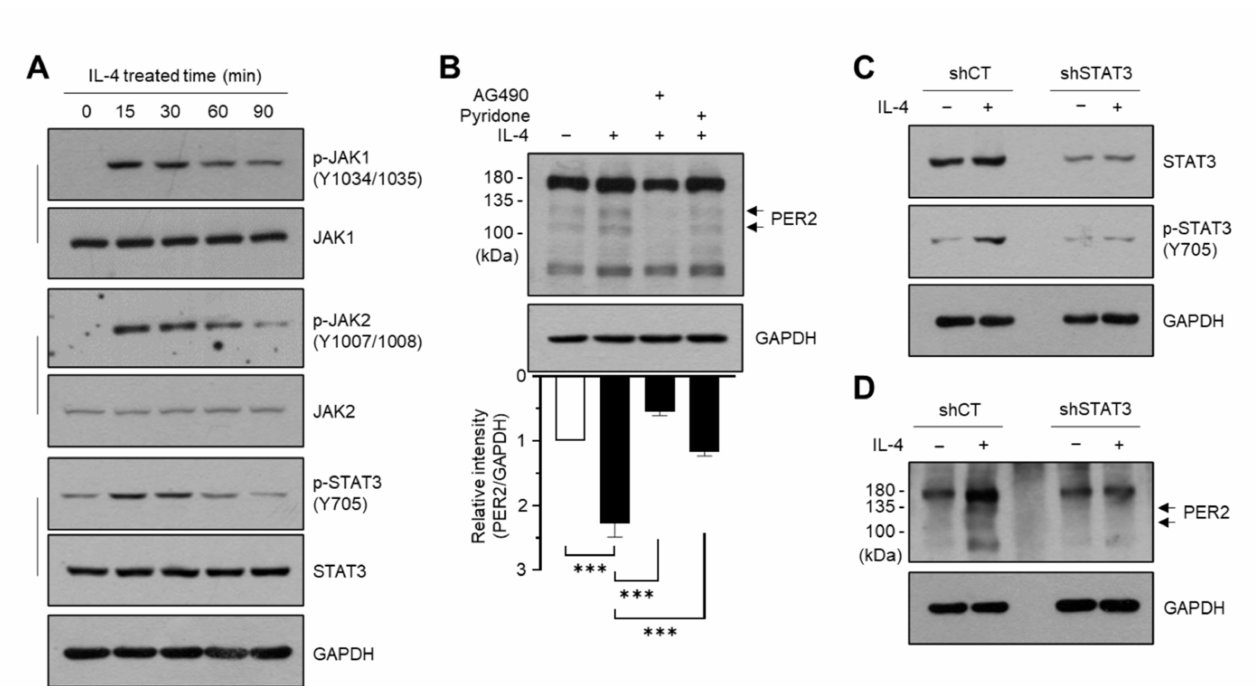
Figure 2. Role of the JAK/STAT3 pathway in IL-4-induced PER2 expression. ( A ) HaCaT cells were treated with 20 ng/mL IL-4 for different periods (0–60 min). Whole-cell lysates were prepared, and immunoblotting was performed using phosphorylation-specific or total protein antibodies. GAPDH was used as an internal control. Uncropped blots are shown in Figure S2. ( B ) HaCaT cells were treated with 20 ng/mL IL-4 for 24 h in the absence or presence of 40 µ M AG490 and 6.2 µ M pyridone 6. GAPDH was used as an internal control. Relative band intensities were measured using